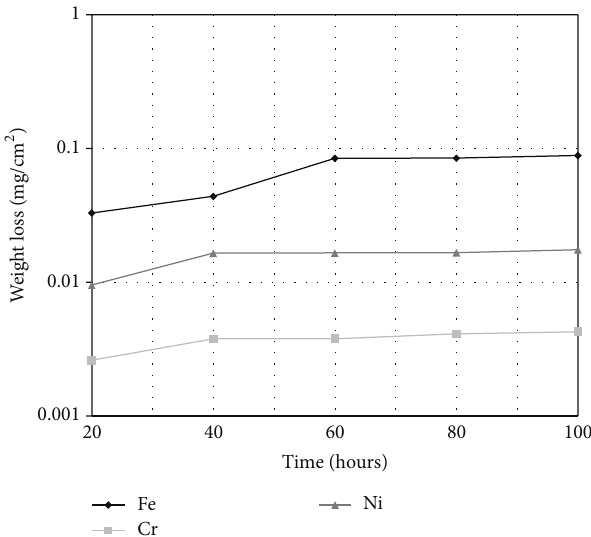
Figure 11: Weight loss for Cr, Ni, and Fe exposed to NaVO 3 at 700 ∘ C in static air.